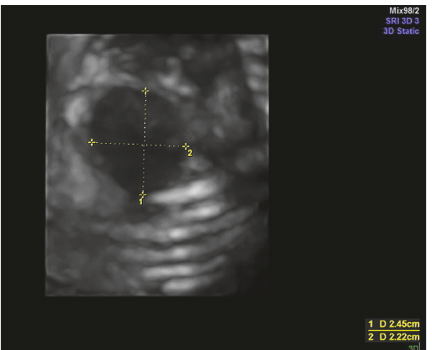
Figure 2: Rib defect and hernia orifice on 3D